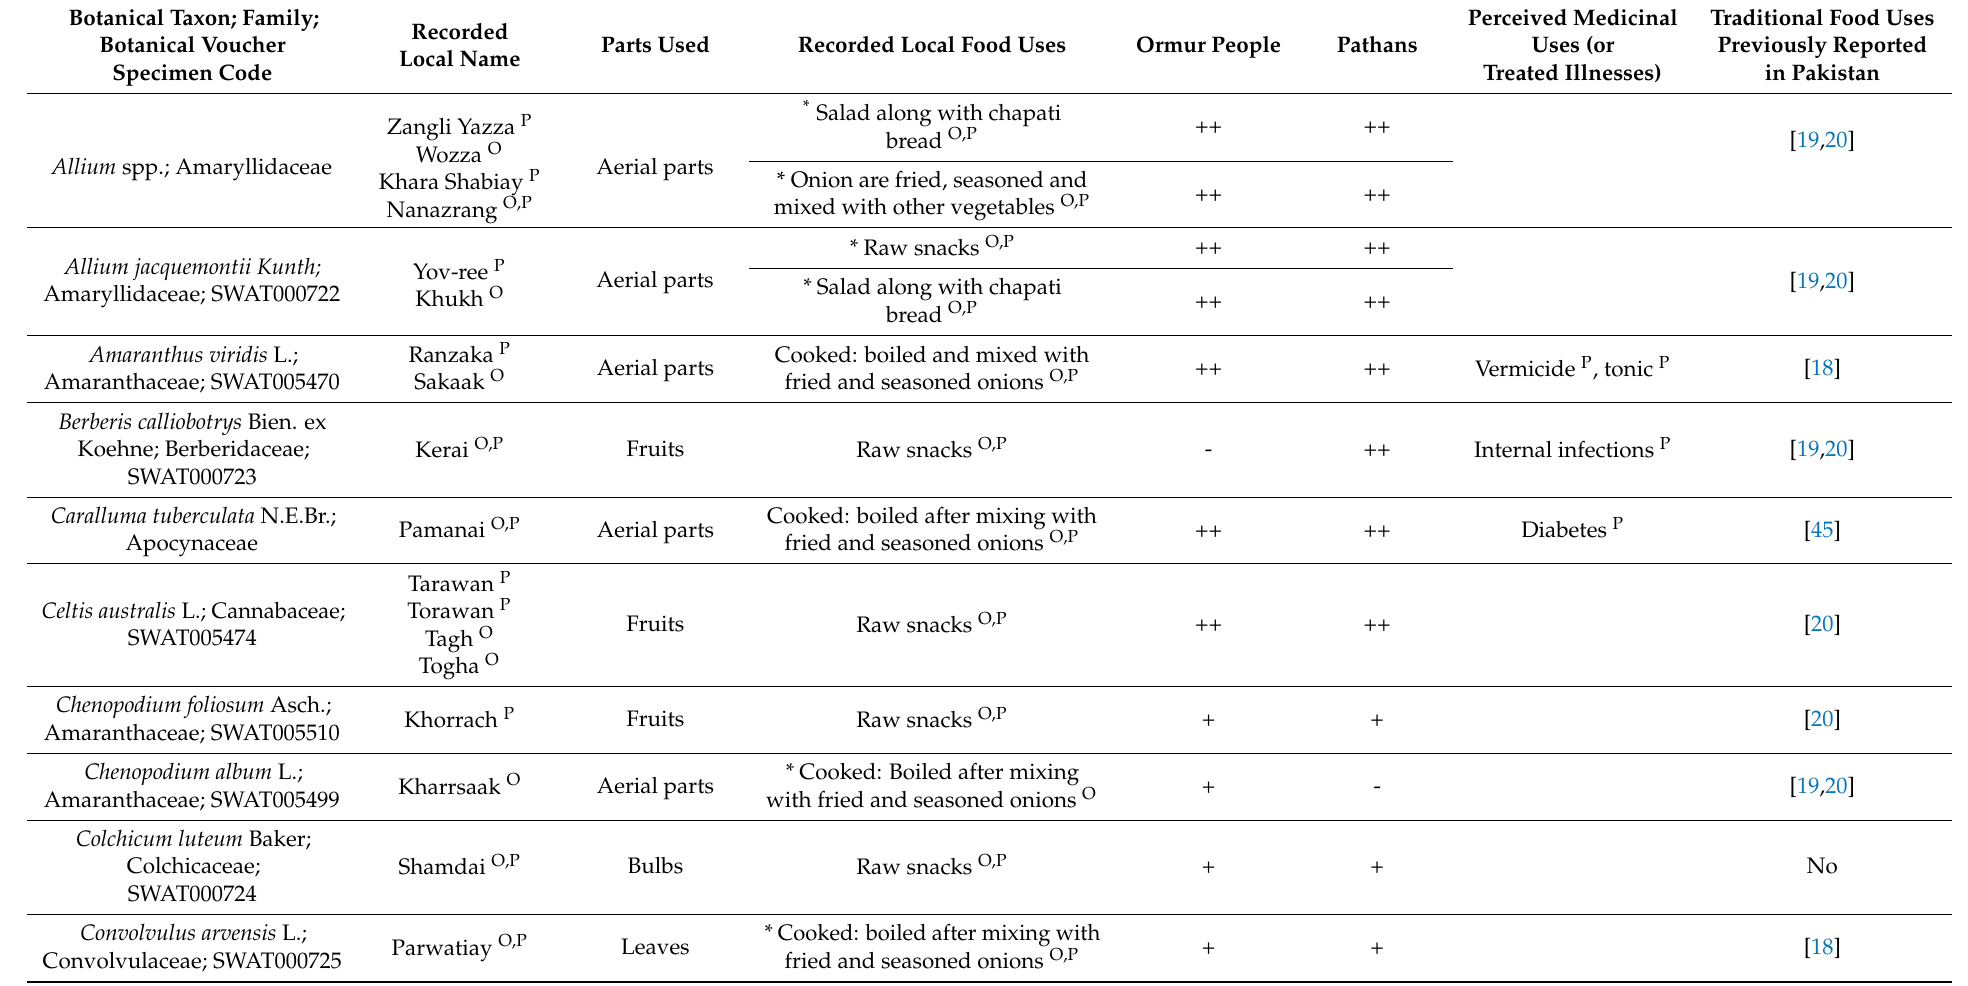
Table 1. Traditional uses of non-cultivated plants used among the studied communities in Kaniguram, South Waziristan (bold superscripts represent those uses quoted by more than 50% of the study participants within the two considered